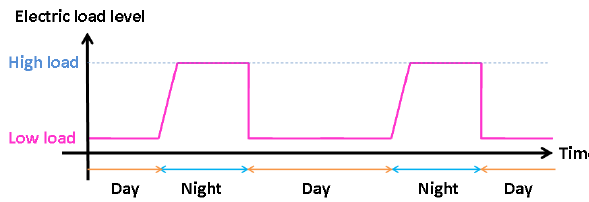
Fig. 3. Periodic electric load pattern applied to the electric furnace.